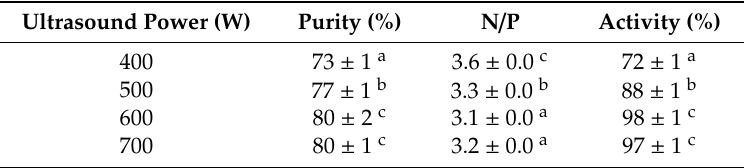
Table 3. Effect of ultrasound time (min) on purity, N/P and activity of Pv.